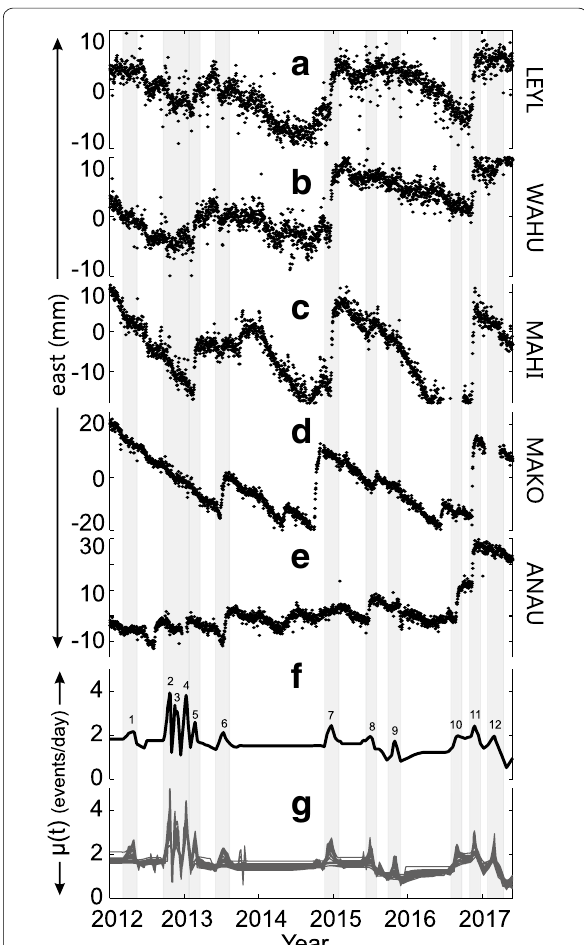
Fig. 8 Association of slow slip earthquakes and the peaks in the estimated background rate. The east component of the displace- ment recorded by the LEYL, WAHU, MAHI, MAKO and ANAU cGPS stations are shown ( a – e ) and compared with the background rate ( f ) estimated using the non-stationary ETAS model with adaptive roughness penalty using M = 150 and M τ = 30 . Note that the peaks in the estimated background rate correspond well with the reversals in the displacement that indicate slow slip earthquakes. Also shown in ( g ) are the estimates obtained using different values of M and M τ , similar to Fig. 5